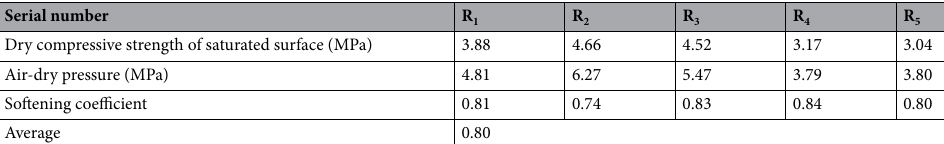
Table 3. The results of softening coefficient. R 1 –R 5 are the numbers of the results that the ratio of the compressive strength of the five samples in the saturated dry state to the compressive strength of the five samples in the air-dry state.